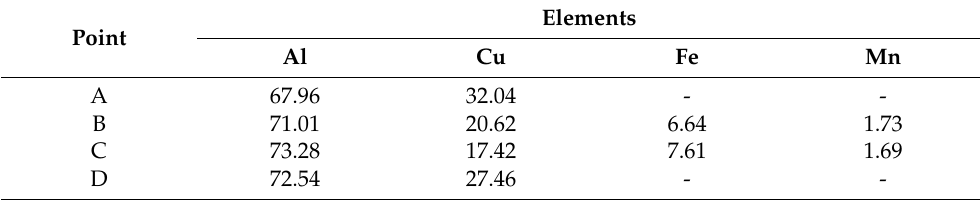
Table 2. SEM-EDS analysis results of the un-dissolved particles shown in Figure 6 (at.